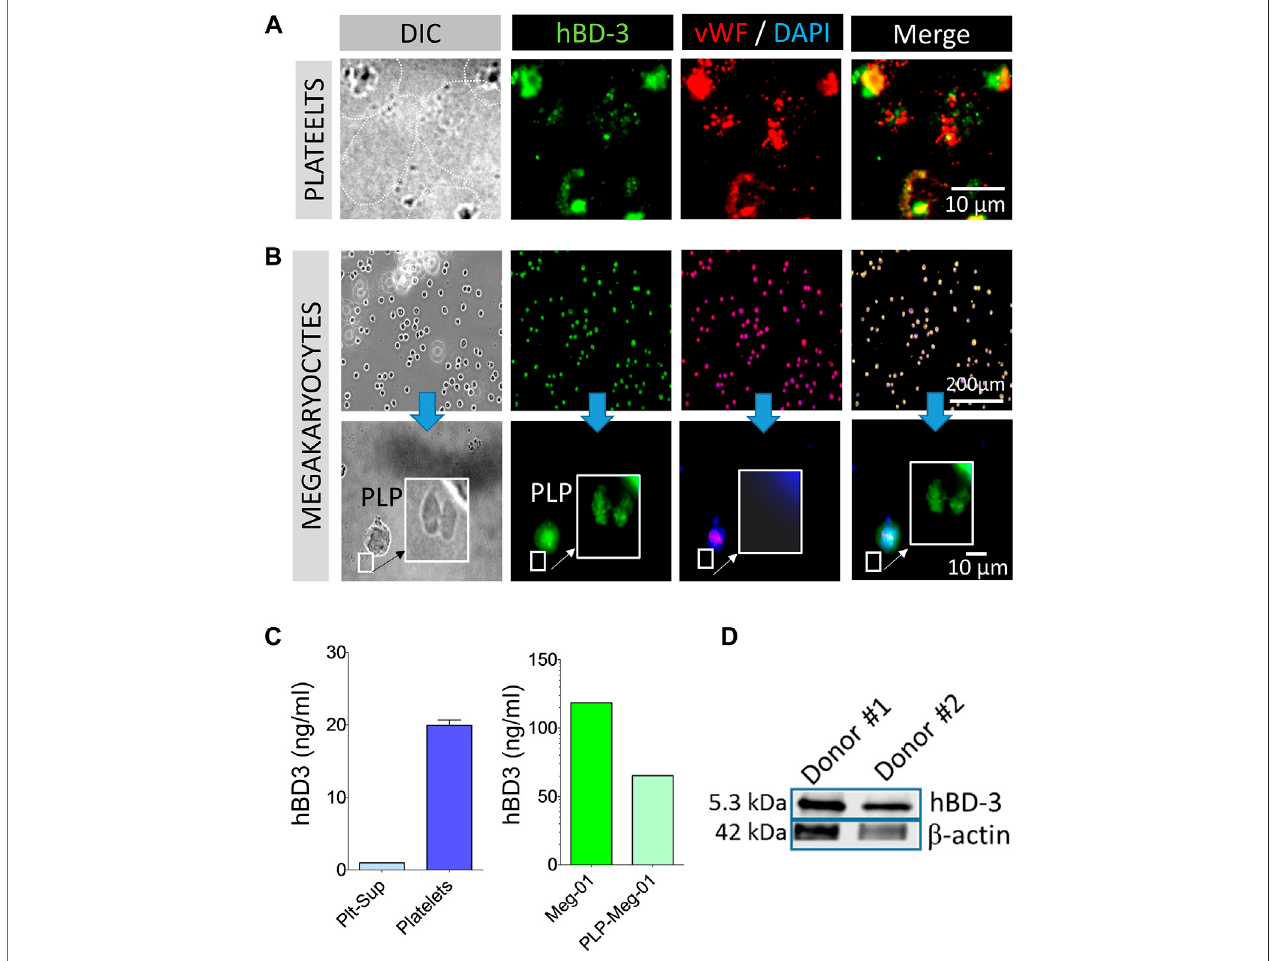
FIGURE1 | Human β -defensin 3(hBD-3) is associated with platelets and megakaryocytes. (A,B) Gel-puri fi ed human platelets spread on fi bronectin coated slides, megakaryocytes (Meg-01), and Meg-01 derived platelet like particles (PLP) were immuno-stained with hBD-3 and von Willebrand Factor (vWF) primary antibodies and respective fl uorescently labelled secondary antibodies. (C) Gel-puri fi ed human platelet supernatant from thrombin activated platelets, Meg-01 lysate and, platelet-like particles (PLP) isolated from TPO activated Meg-01 culture supernatant (PLP-Meg-01), were treated with 0.1% SDS, normalized for total protein contents, and hBD-3 concentrations were measured by ELISA. (D) Representative western blot image of hBD-3 protein expression in platelets from two healthy